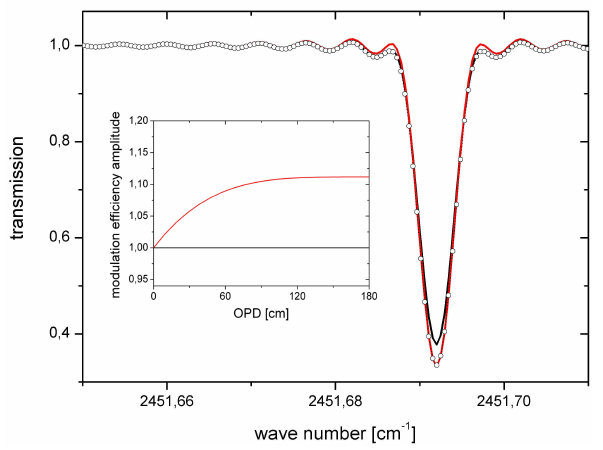
Fig. 2. The normalized modulation efficiency and phase error de- rived from the HBr cell spectrum shown in Fig. 1.